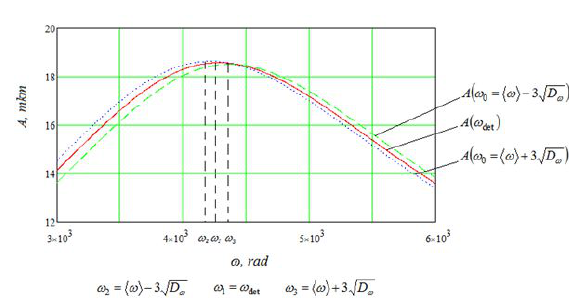
Figure 2: Amplitude-frequency characteristics of automatic bal- ancing device with taking into account random changes of basic parameters of face